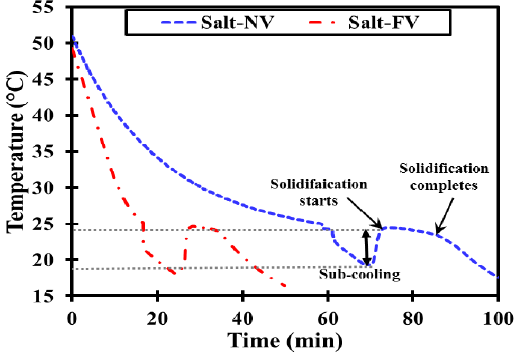
Figure 10. Transient cooling curve for salt represented by HS bottom surface temperature under NV and